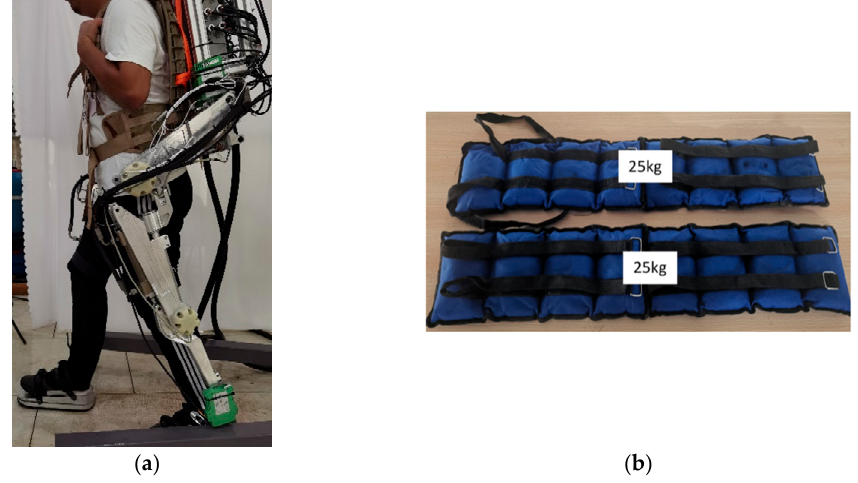
Figure 30. Endurance test. ( a ) The exoskeleton; ( b ) Sand bag. After 20 groups of tests, the test data are shown in Table 5. Table 5. Data for endurance